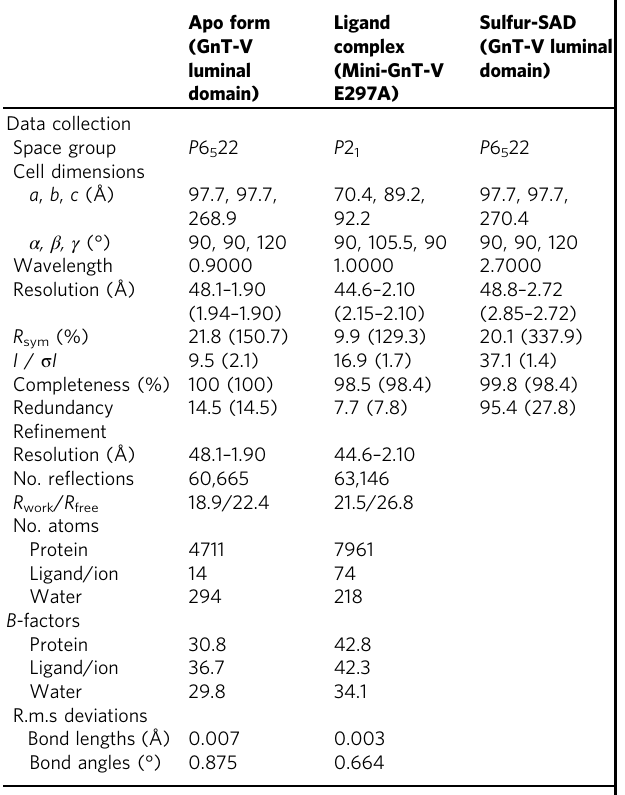
Table 2 Data collection and re fi nement